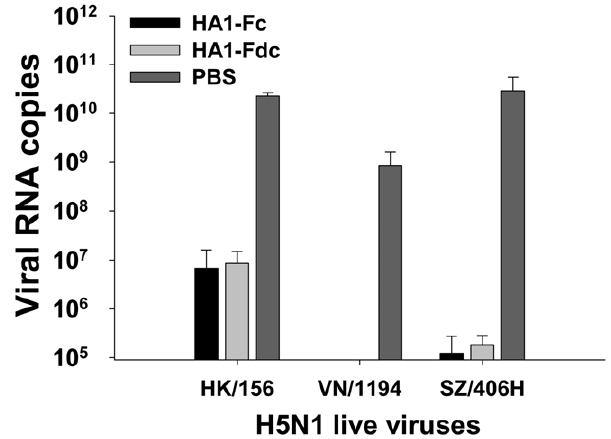
Figure 7. Detection of viral RNA copies by quantitative reverse- transcription PCR (Q-RT-PCR) in lung tissues of H5N1 virus- challenged mice. Titers of HK/156, VN/1194 and SZ/406H H5N1 virus were determined in lung tissues of the mice vaccinated with HA1-Fc and HA1-Fdc proteins, respectively. Mice vaccinated with PBS were used as the negative control. The data are expressed as mean 6 SD of RNA copies per lung tissues from five mice per group.